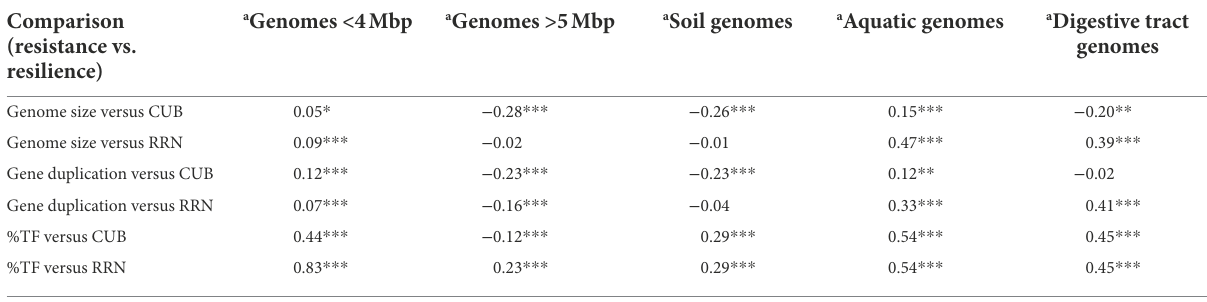
TABLE 2 Correlation coefficients (Spearman rank correlation) between selected resistance and resilience related traits for species with small and large genomes. Comparison (resistance